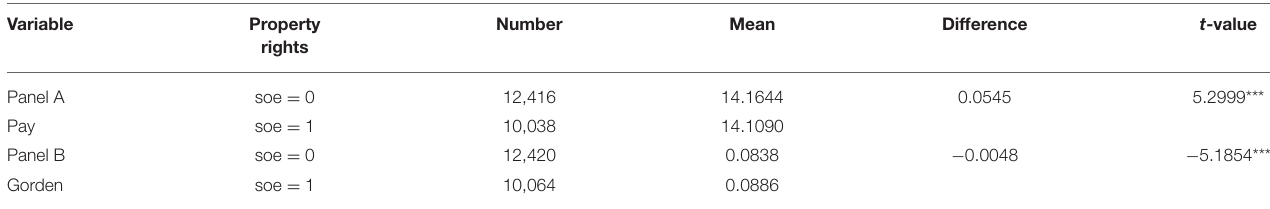
TABLE 4 | Univariate t -test.